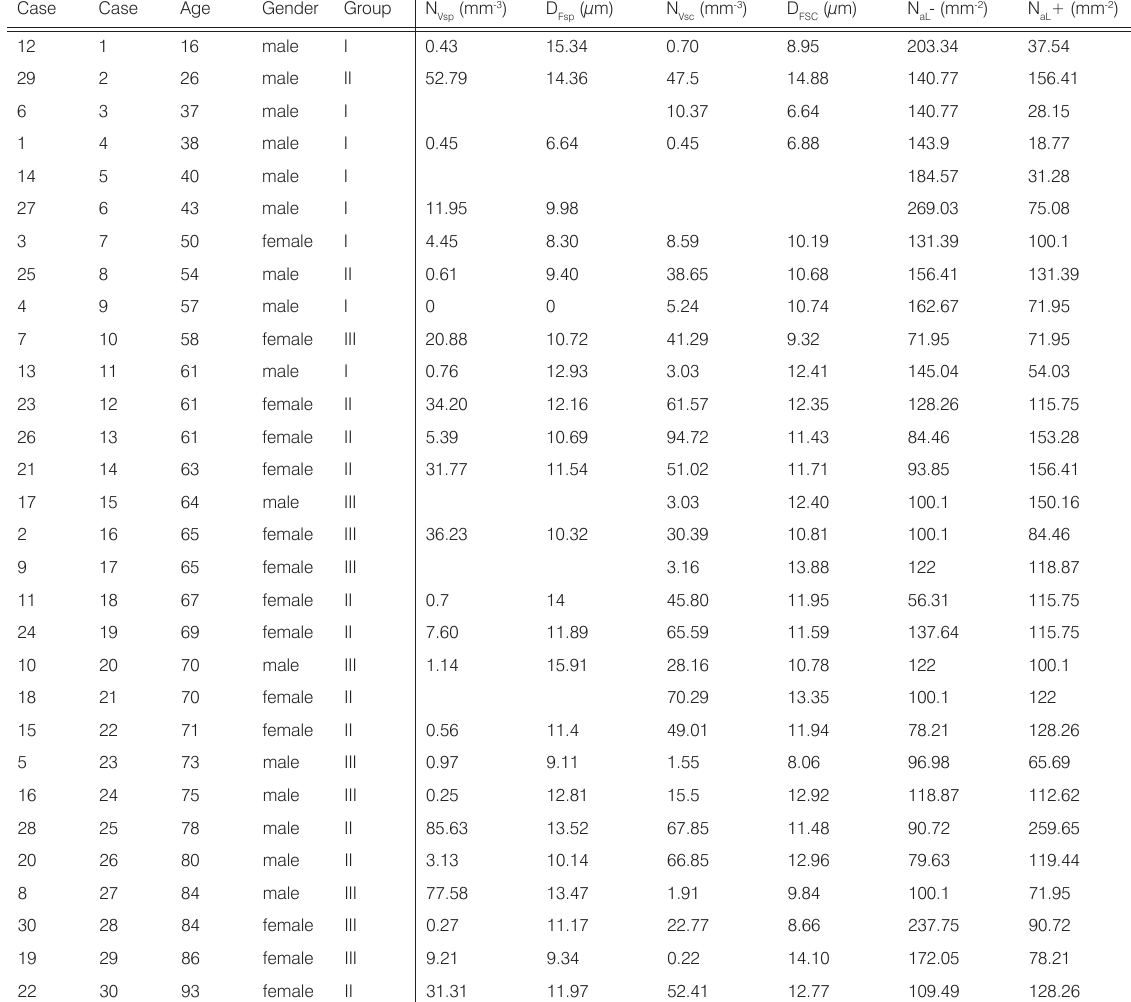
Table 1. Morphometric characteristics of the CA and lipofuscin-bearing neurons in the parahippocampal gyrus cortex of all evaluated cases